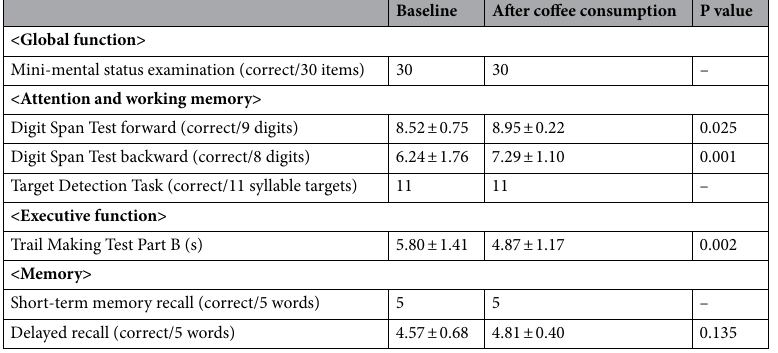
Table 1. Results of neuropsychological tests. Values represent mean ± standard